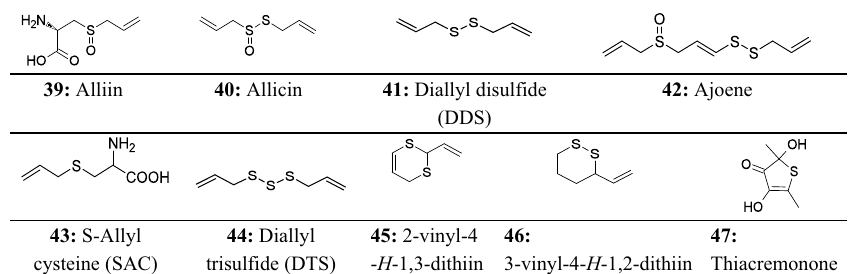
Fig. 5: Structures of organosulfur compounds found in garlic ( 39 - 47